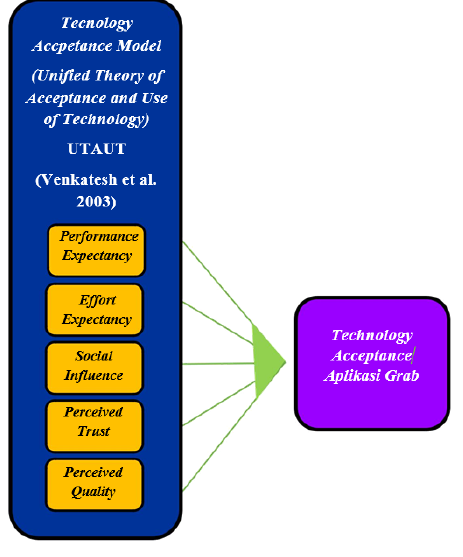
Fig. 1 Conceptual